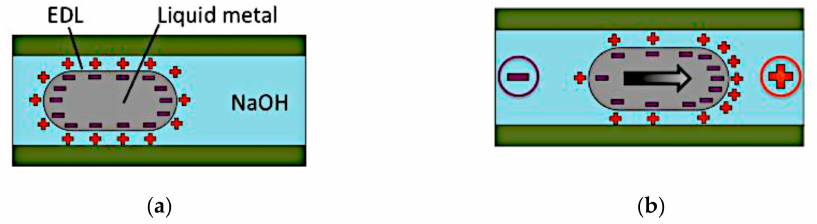
Figure 3. ( a ) Liquid metal in an electrolyte. ( b ) Potential gradient across the electrolyte